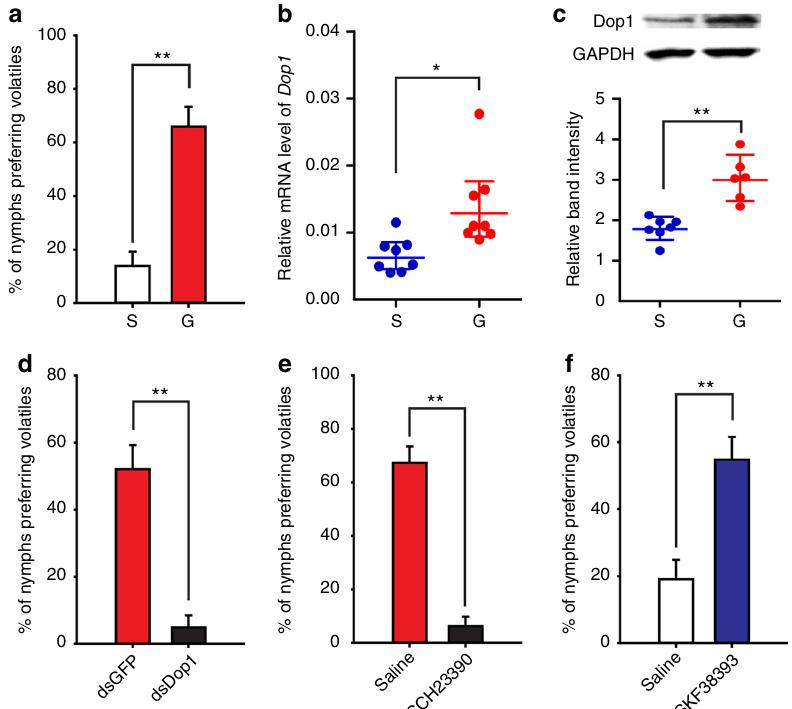
Fig. 1 Dop1 regulates the olfactory attraction to gregarious volatiles in the migratory locust. a Gregarious locusts showed higher olfactory preference for gregarious volatiles than solitarious locusts ( n = 44 and 41, G -test). b , c Dop1 mRNA ( b , n = 8) and protein levels ( c , n = 6) signi fi cantly differed in the brains of solitarious and gregarious locusts (Student ’ s t -test). d Dop1 RNAi knockdown reduced the olfactory response of gregarious locusts to their volatiles ( n = 48 and 40). e Injection of the Dop1 antagonist SCH23390 reduced the olfactory response of gregarious locusts to their volatiles ( n = 54 and 48). f Injection of the Dop1 agonist SKF38393 enhanced the olfactory preference of solitarious locusts to gregarious volatiles ( n = 47 and 41). The asterisks outside the strip indicate the signi fi cant difference between controls and the treatments through G -test for independence ( d , e , f ). The data in b and c are shown as mean ± SEM and the data in a , d , e , and f are shown as proportion ( p ) ± SE * P < 0.05; ** P < 0.01. S: solitarious, G: